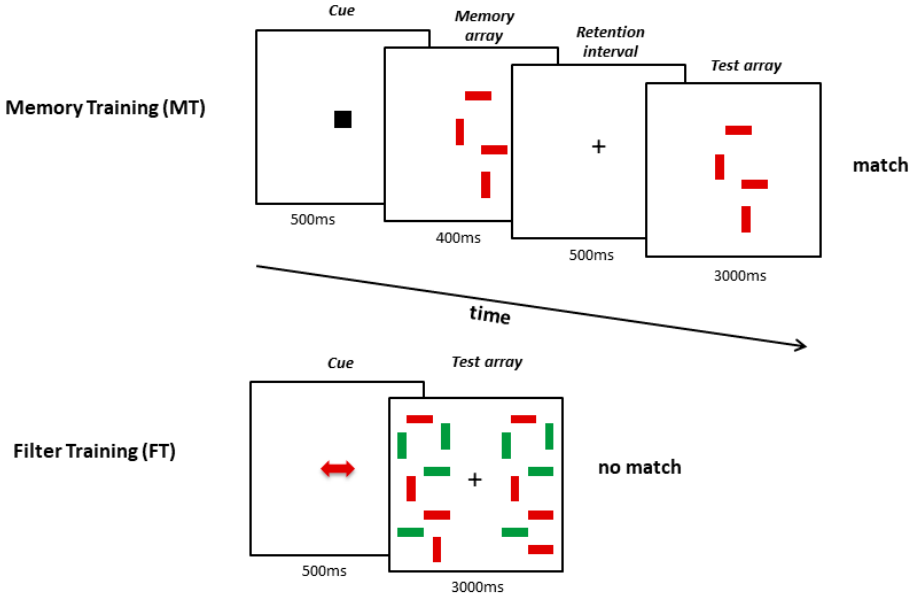
Figure 2. Schematic representation of Memory and Filter Training.